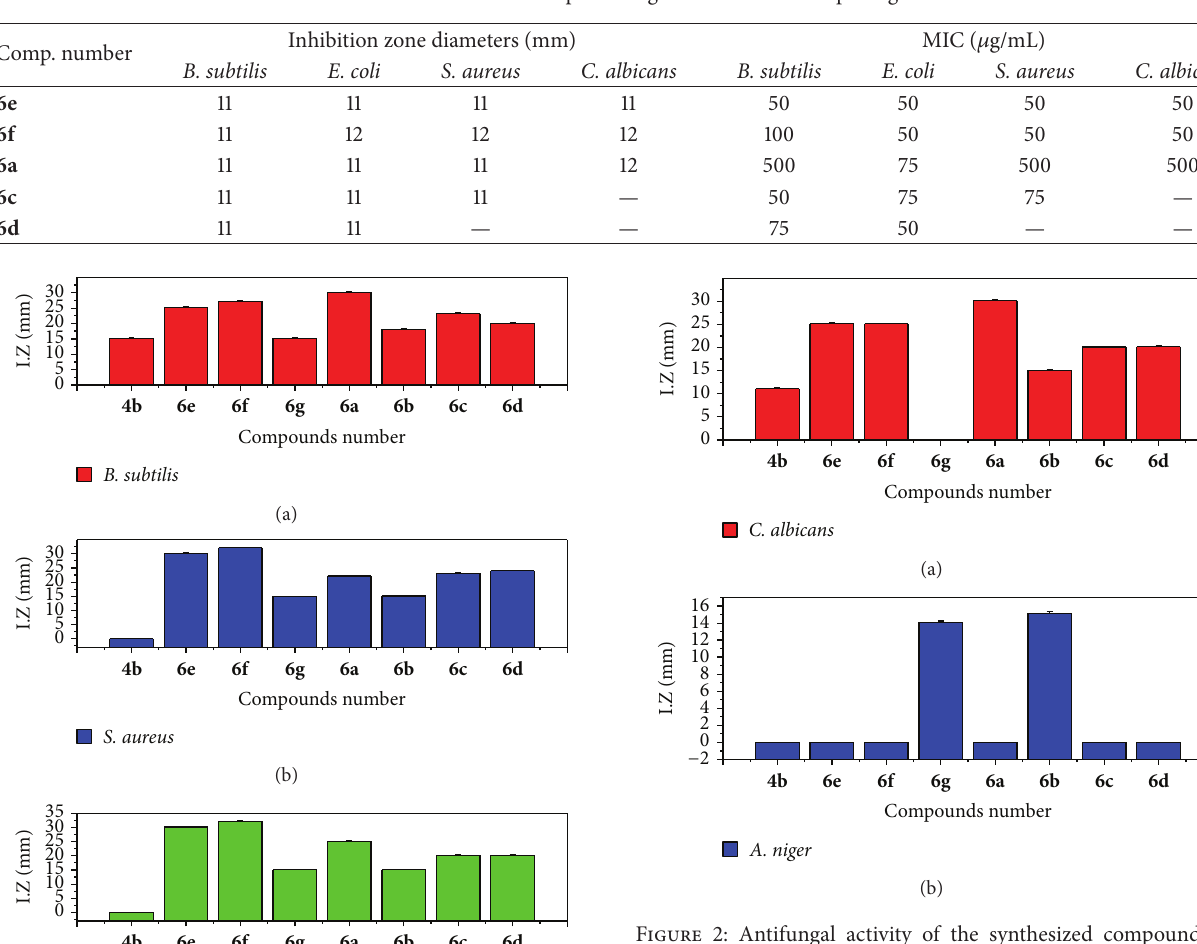
Figure 2: Antifungal activity of the synthesized compounds at concentration of 10mg/mL: (a) C. albicans and (b) A. niger